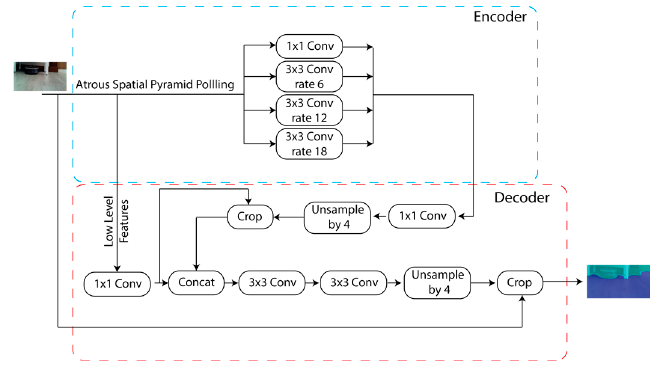
Figure 5. Semantic Segmentation Network layer structure.